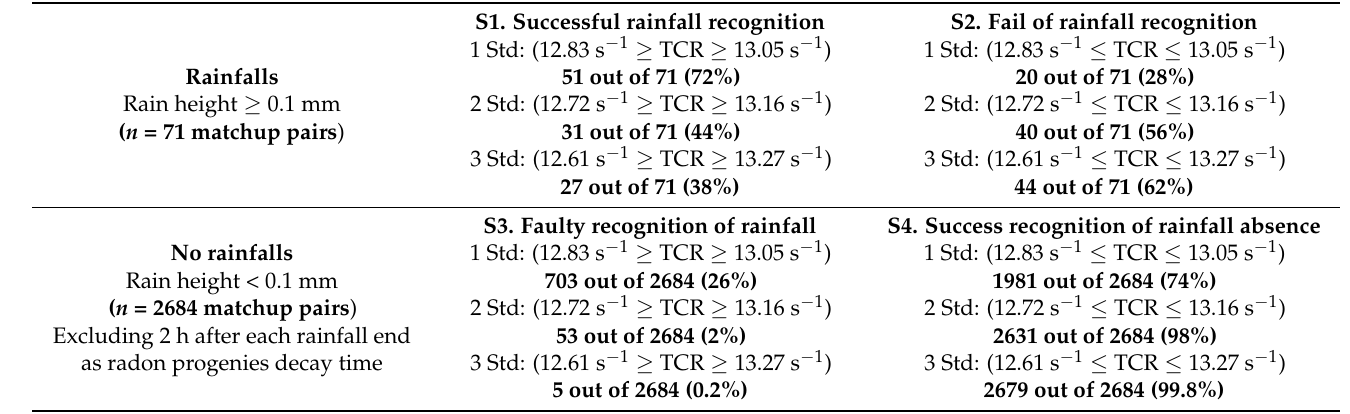
Table 1. Evaluation using TCR statistical criteria to rainfall recognition according four scenarios S1 – S4 : success ( S1 ) or miss ( S2 ) of rainfall recognition when the rain gauge recorded rainfall, failure ( S3 ) or success ( S4 ) to discriminate rainfall absence when the rain gauge recorded no